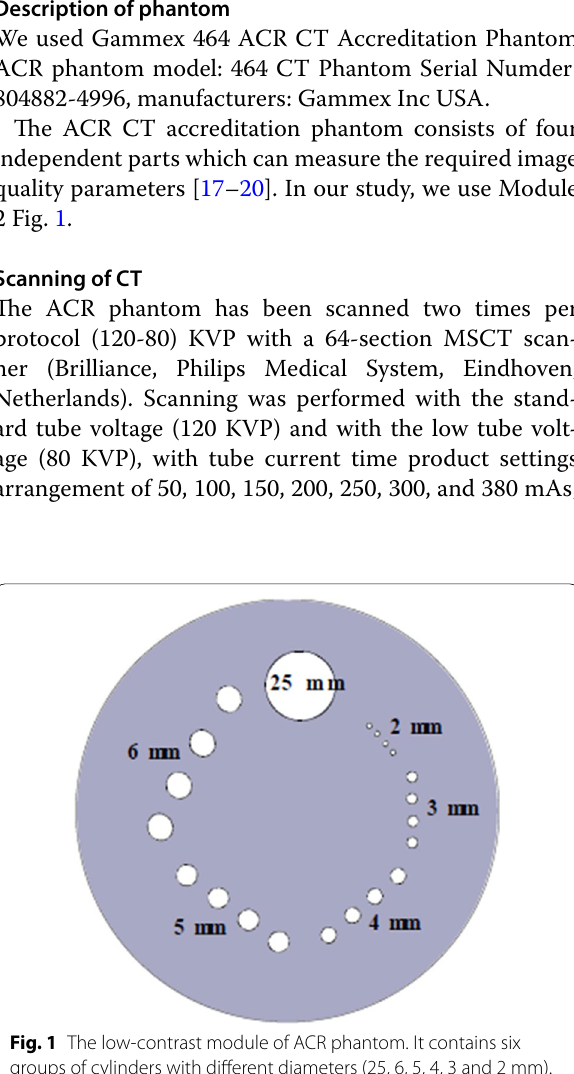
Fig. 2 Scatter diagram for positive correlation between CTDI vol and